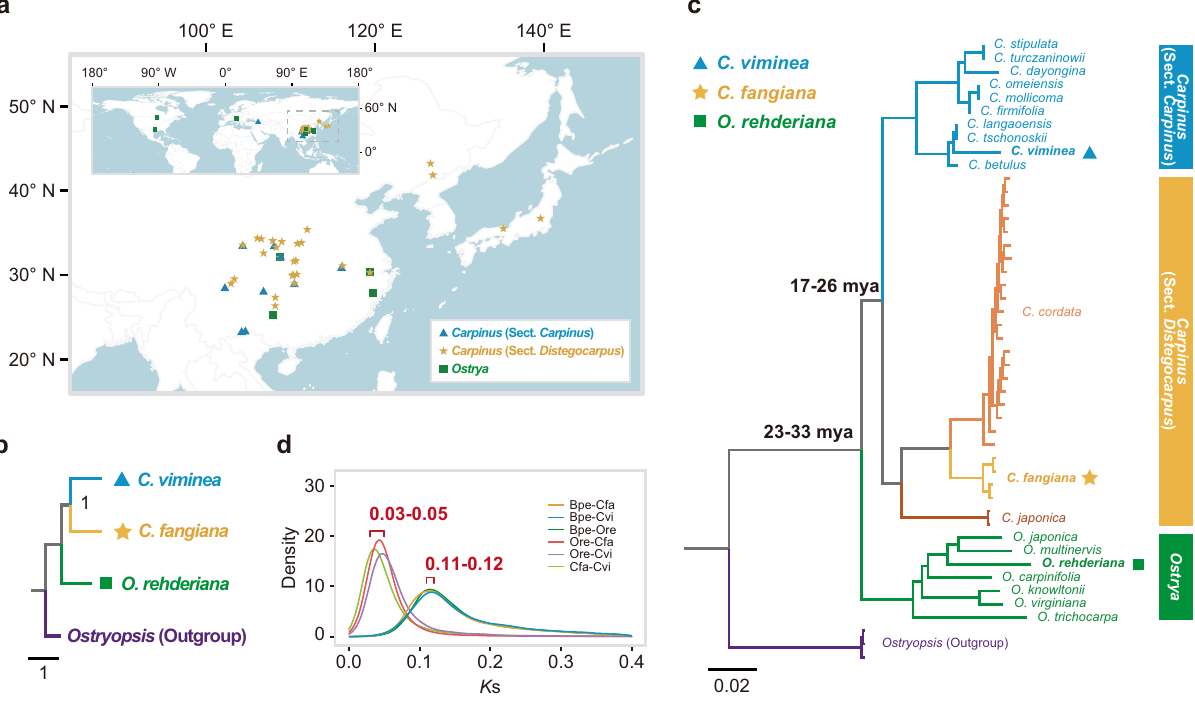
Fig. 2 Sample locations and phylogenetic analyses. a Geographic distributions of sampling locations for three lineages. b Coalescent-based species tree reconstructed using 6321 strictly orthologous nuclear gene groups by ASTRAL. The support values are estimated by local posterior probability. c Phylogeny of all re-sequenced samples based on analyses of nuclear SNPs. The bootstrap values for interspeci fi c nodes were all 100. d K s distributions between members of each pair of species. Betula pendula (Bpe) was used as the outgroup to date the times of divergence between it and Ostrya rehderiana (Ore), Carpinus viminea (Cvi), and C. fangiana (Cfa). The estimated divergence times are shown in ( c ). Source data are provided as a Source Data fi